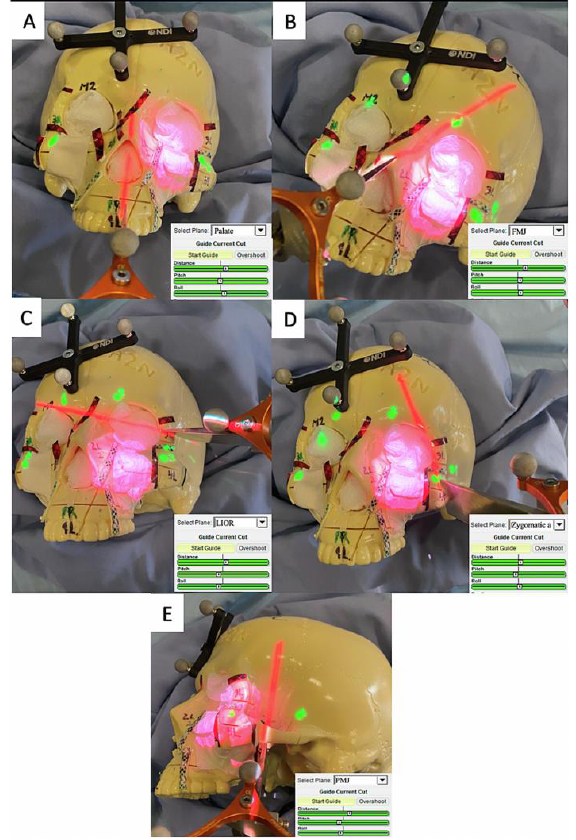
Figure 4. Example of the different AR projected osteotomies required to resect a left-sided maxillary tumor in sequence, with zoom-ins into the distance pitch and roll cutting parameters projected onto the surgical field: ( A ) palate, ( B ) fronto-maxillary junction, ( C ) lower inferior orbital rim, ( D ) zygomatic arch, and ( E ) pterygomaxillary junction.